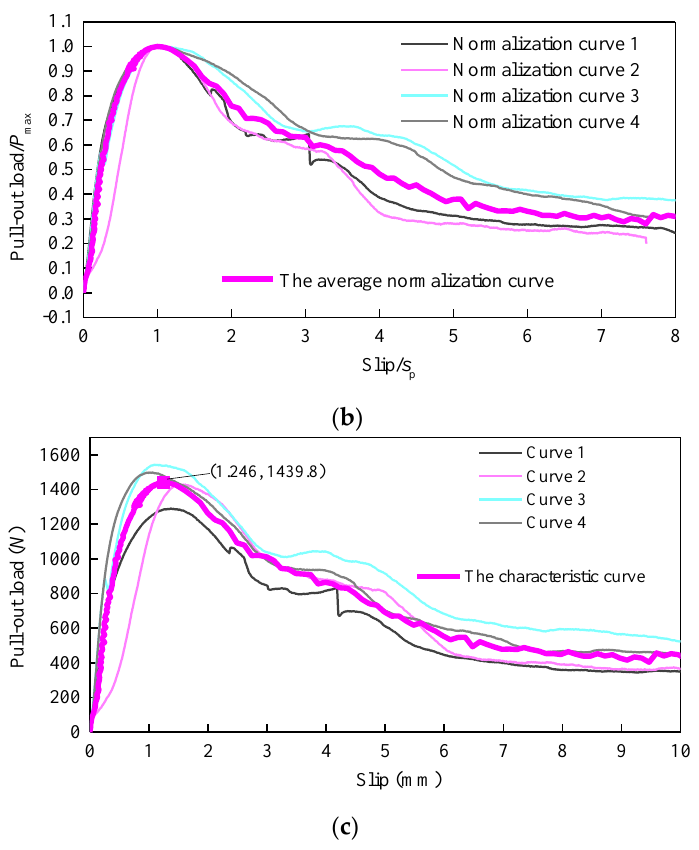
Figure 7. An example of determining the characteristic pull-out load-slip curve: ( a ) four test curves; ( b ) the normalized curves; ( c ) the characteristic pull-out load-slip curve.